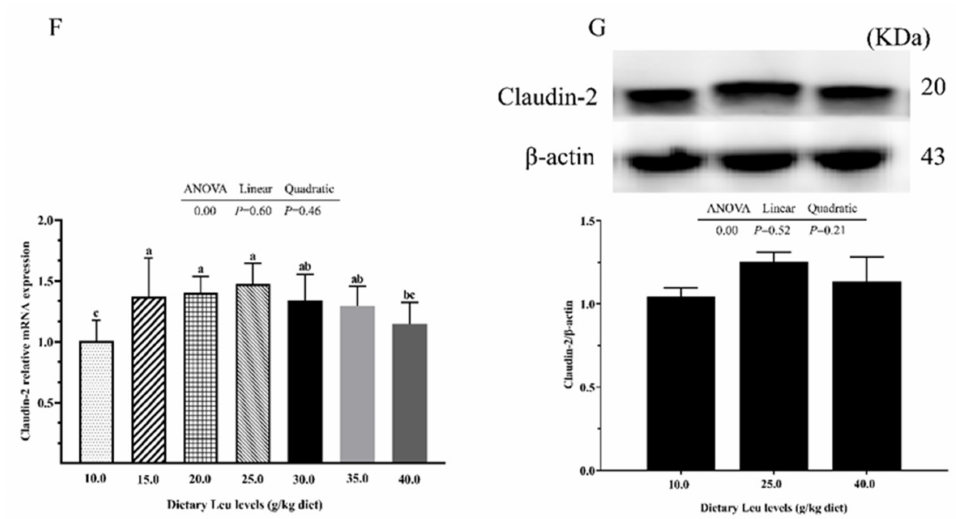
Figure 3. Effect of dietary Leu on TJs in intestine of hybrid catfish fed diets with graded levels of Leu (g/kg) for 56 days. ( A ) IHC staining analysis of occludin and ZO-1 expressions (scale bars: 200 µ m and 50 µ m). ( B , C , F ) The mRNA expressions of occludin, ZO-1, and Claudin-2. ( D , E , G ) The protein levels of occludin, ZO-1, and Claudin-2. All results are represented as means ± SEM (n = 3 × 6). Duncan’s multiple range test was used to detect significance. Different superscripts above the bars indicate significant differences ( p < 0.05).